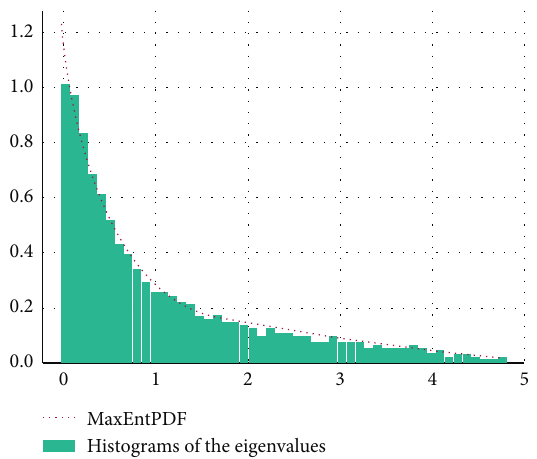
Figure 6: d � 1000, n � 2000, alpha � 0.5, and beta �